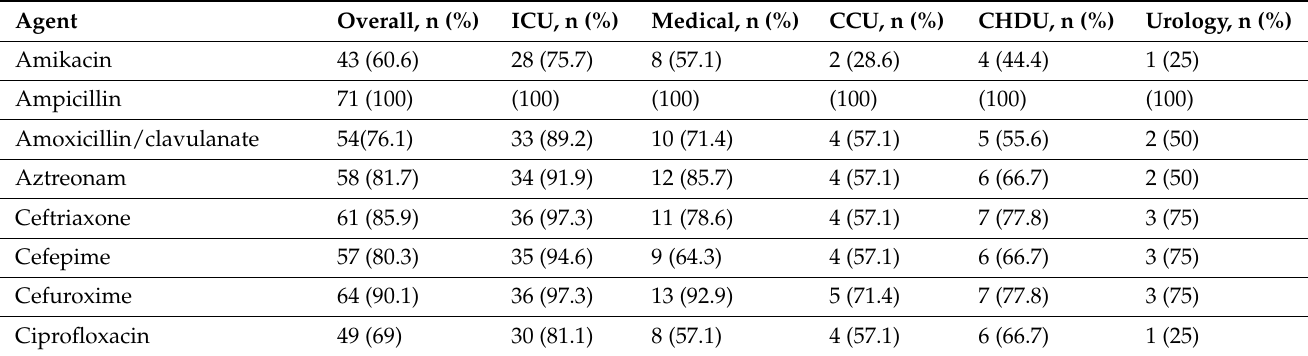
Table 2. Antibiotic resistance rates of MDR Klebsiella pneumoniae (n = 71) collected from comorbidity patients at different hospital’